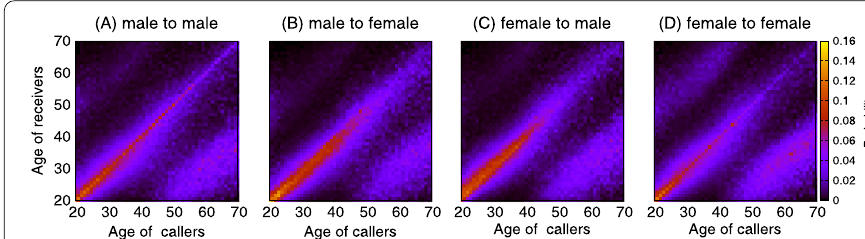
Figure 1 Snapshots of all four possible ways of interaction: ( A ) male to male, ( B ) male to female, ( C ) female to male, and ( D ) female to female, are shown by considering only calls of duration more than one minute and caller and callee ages from 20 years to 70 years. For given age and gender of callers, the calling probability is calculated as the ratio between total number of calls to callees of specific age and the total number of calls